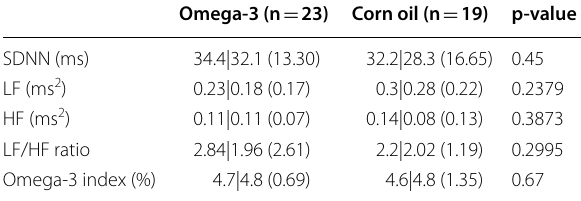
Table 4 Baseline values: mean/median